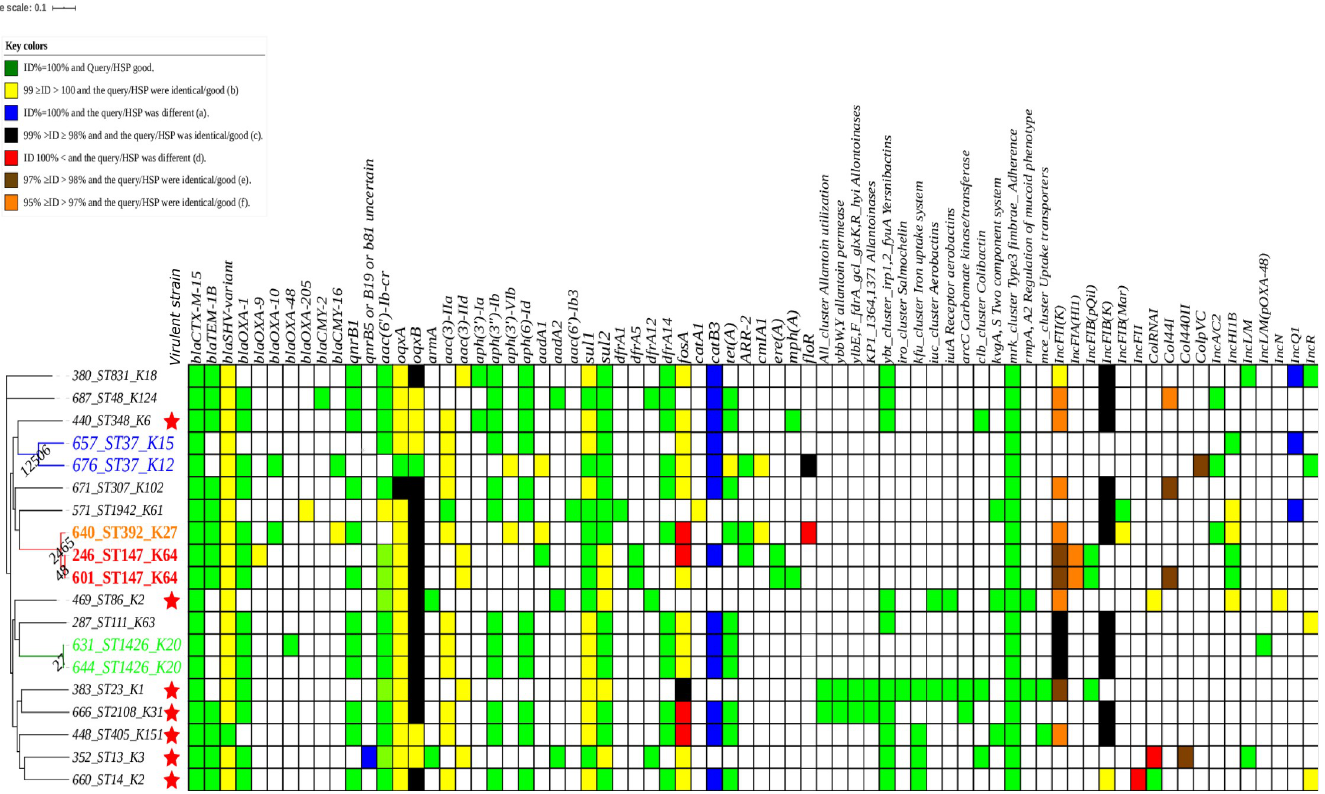
Fig 4. Heatmap with all results (resistance genes, virulence, MLST, K-types, replicons with the ML Tree from the SNP-based analysis) among the sequenced 19 isolates. The scale is